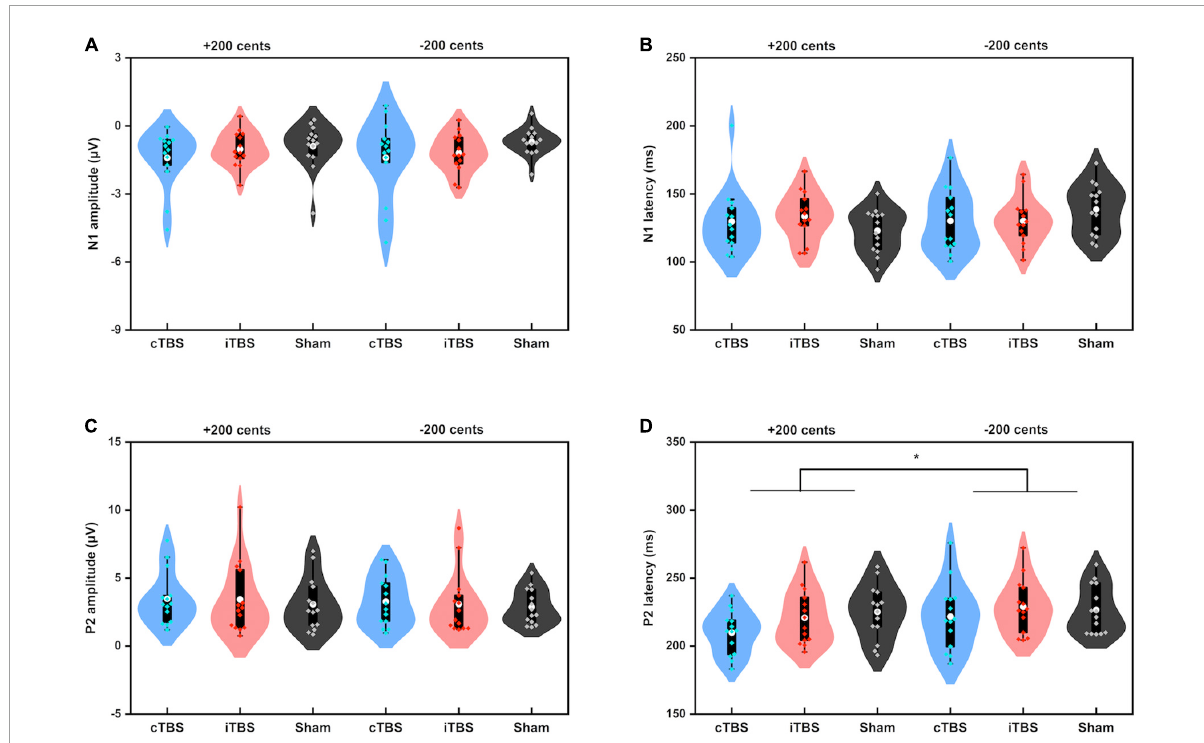
FIGURE6 Violin plots of the amplitudes and latencies of the N1 (A,B) and P2 (C,D) responses to pitch perturbations of ± 200 cents produced by all participants across the conditions. The white dots and box plots represent the medians and ranges from first to third quartiles of the data sets. The blue, red, and black dots represent the individual vocal responses to pitch perturbations following cTBS, iTBS, and sham stimulation over the left cerebellar lobule VII (Crus I). The asterisk indicates a significant difference in the P2 latency between + 200 and − 200 cents perturbations. CB,